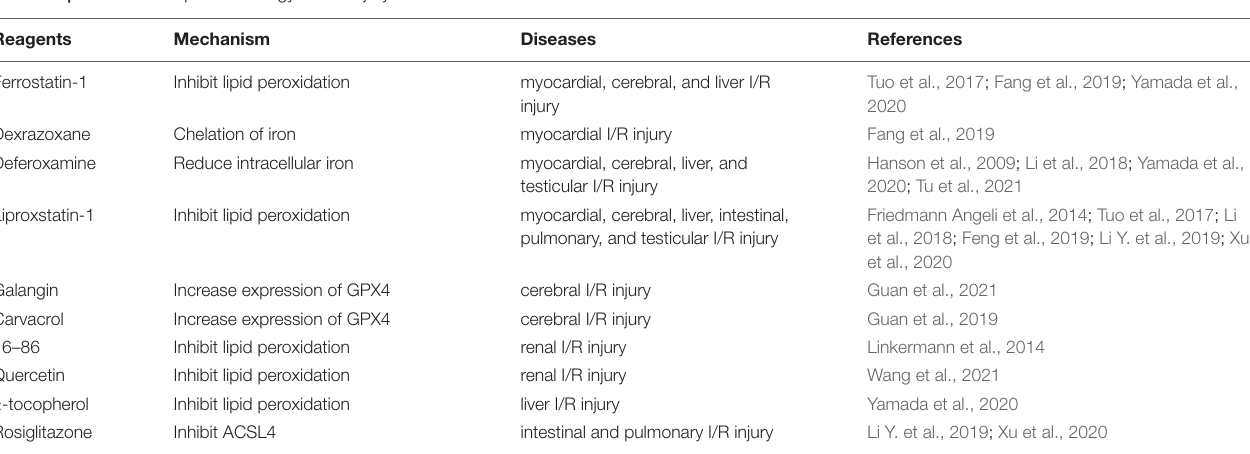
FIGURE 2 | The link between ferroptosis and I/R injury. An I/R injury causes iron accumulation and ROS generation, leading to lipid peroxidation and ferroptosis. Ferroptosis further enlarges I/R injuries; however, iron chelators and ferroptosis inhibitors improve the damage caused by I/R. TABLE 2 | Potential therapeutic strategy for I/R